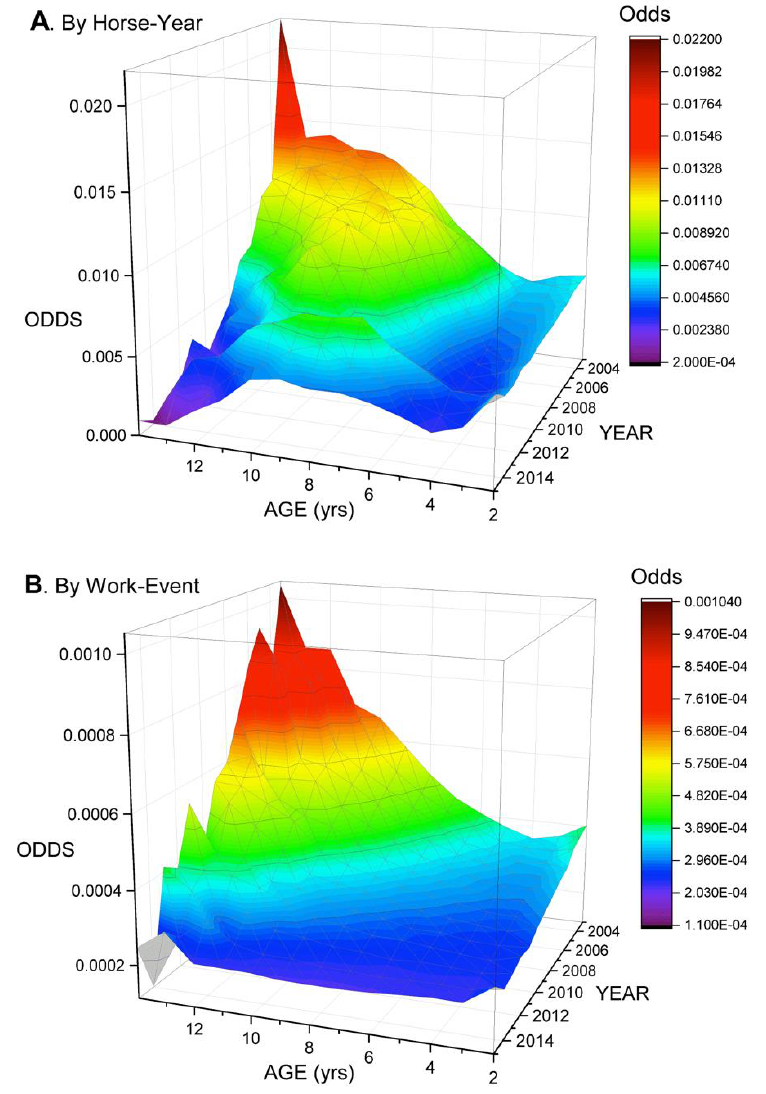
Figure 5. Odds of mortality, by YEAR and AGE, for standardbred horses racing in the Province of Ontario from 2003–2015 and describing an AGE × YEAR interaction identified through logistic regression analysis of mortality data from the Ontario Death Registry. ( A ) Unit of interest-horse-year. Population-all horse-years ( n = 125,200). When all other effects are held constant, odds of mortality by horse-year decline by YEAR over the study period and show a declining effect of AGE. The greatest fall is for older horses, while mortality odds for younger horses decline far less over the study period. ( B ) Unit of interest-work-event. Reference population-all work-events ( n = 1,778,330). A similar decline is evident in mortality by work-event. There was no significant change in population distribution by AGE over the study period. Note the difference in scale between the two images, mortality odds by horse-year being 20 times higher than by work-event, a reflection of the number of annual work-events undertaken by horses.